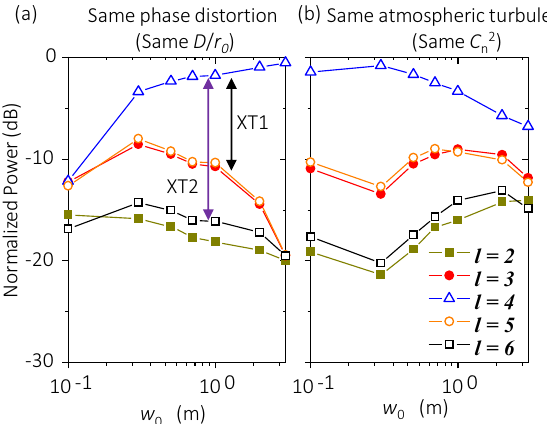
Figure 5. Effects of varying the transmitted beam waist on normalized power distribution on different OAM modes. ( a ) a 500-m link with D / r 0 = 0.224 at the transmitter side, and ( b ) a 500-m link with C OAM + 4 at f = 0.5 THz is transmitted. Legends and scales in y -axis in ( a , b ) are the